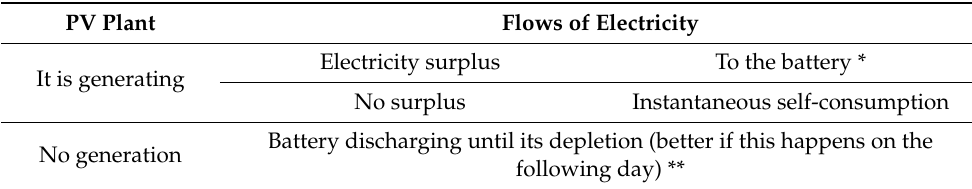
Table 2. The mPVG with self-sufficiency priority. PV